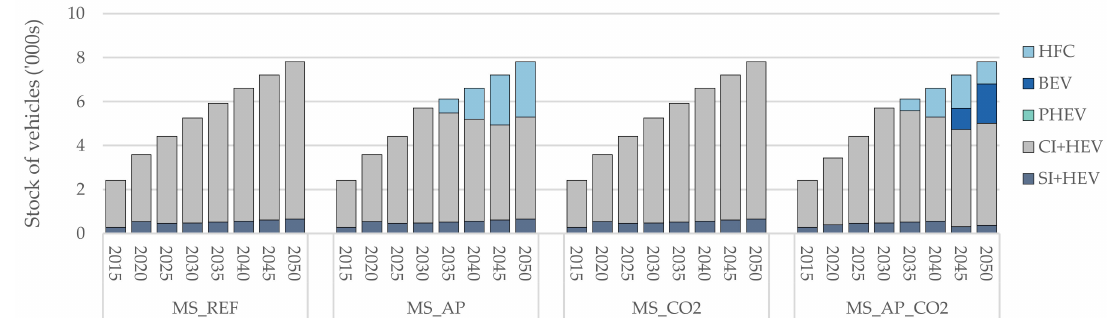
Figure A4. Total stock of buses, medium-sized goods vehicles (MGVs) and heavy goods vehicles (HGVs) in the mode shift (MS) scenarios (‘000s). Note : HFC = hydrogen fuel cell vehicle; BEV = battery electric vehicle; PHEV = plug-in hybrid electric vehicle; CI + HEV = Conventional + non-plug-in hybrid electric compression ignition (CI) vehicle; SI + HEV = Conventional + non-plug-in hybrid electric spark ignition (SI) vehicle.